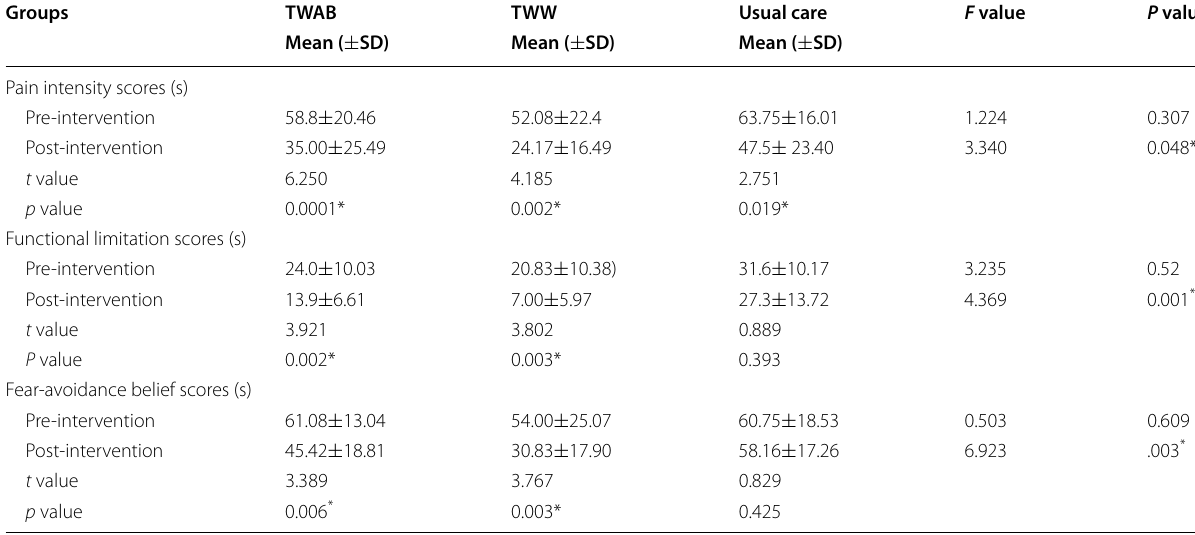
Table 2 Pre- and post-intervention scores of pain intensity. Functional limitation and fear-avoidance behaviours among the participants